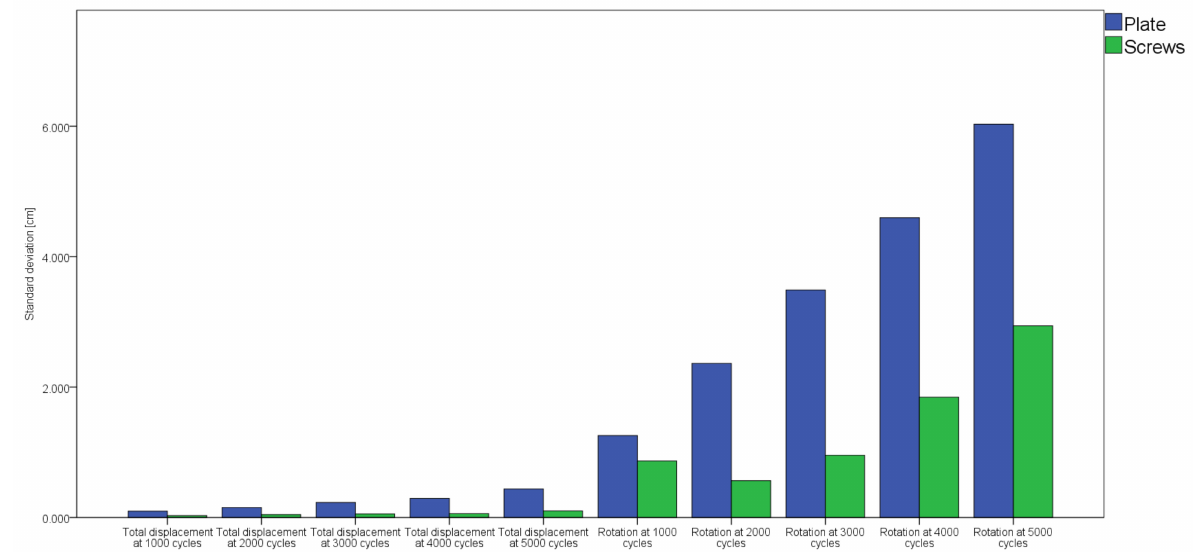
Figure 6. Analysis of the standard deviations revealed their significantly less progressively in increase over cycles in group 2 (screws) versus group 1 (plate) ( p =